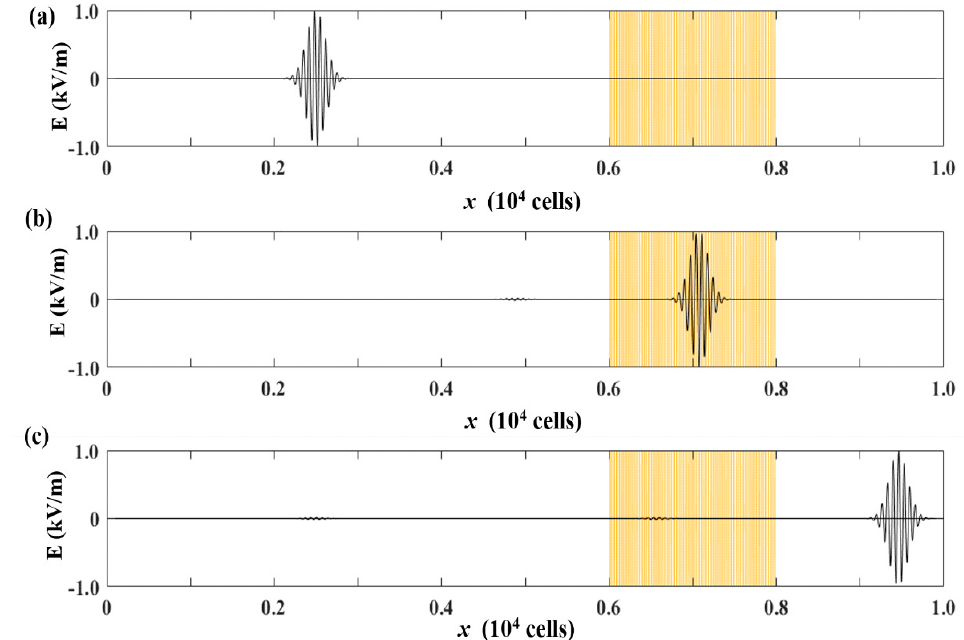
Figure 11. Simulation of a wave propagating in air and striking 1D plasma PhCs with plasma layer thickness d = 2 nm. The plasma has the properties of silver: ω p = 2000 THz, ϑ c = 50 THz. The propagating wave has a center frequency of 4000 THz. ( a , b ) show electric field in the computational domain at different times ( a ) = 0 fs, ( b ) = 15 fs, and ( c ) = 23 fs. (Left side with film thickness of 1000 cells, right side with film thickness of 2000 cells).